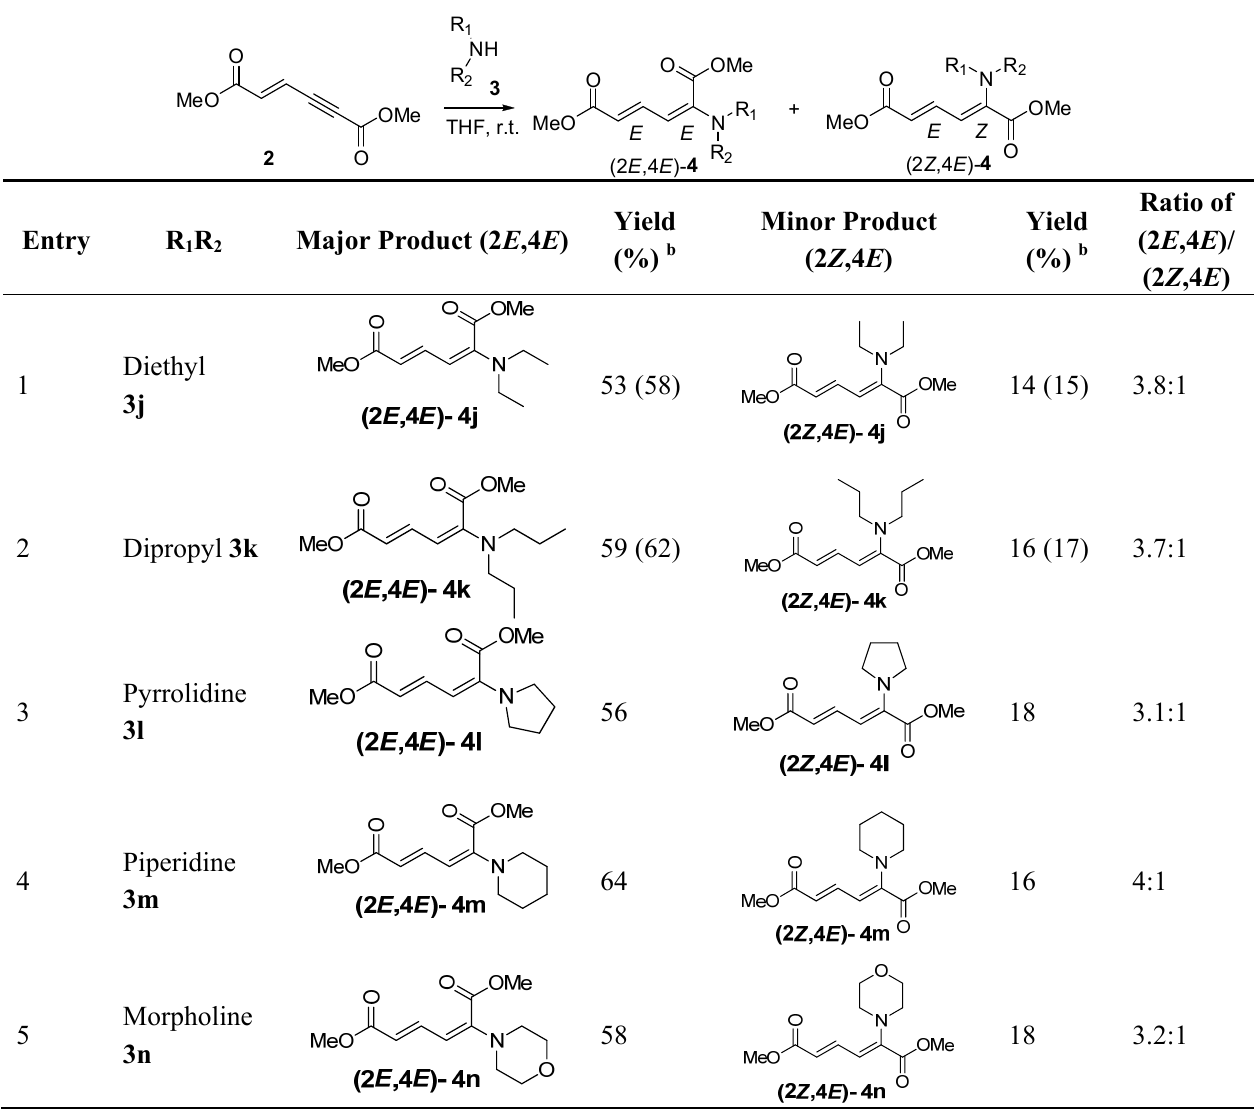
Table 3. Reaction of enyne 2 with secondary alkyl amines a